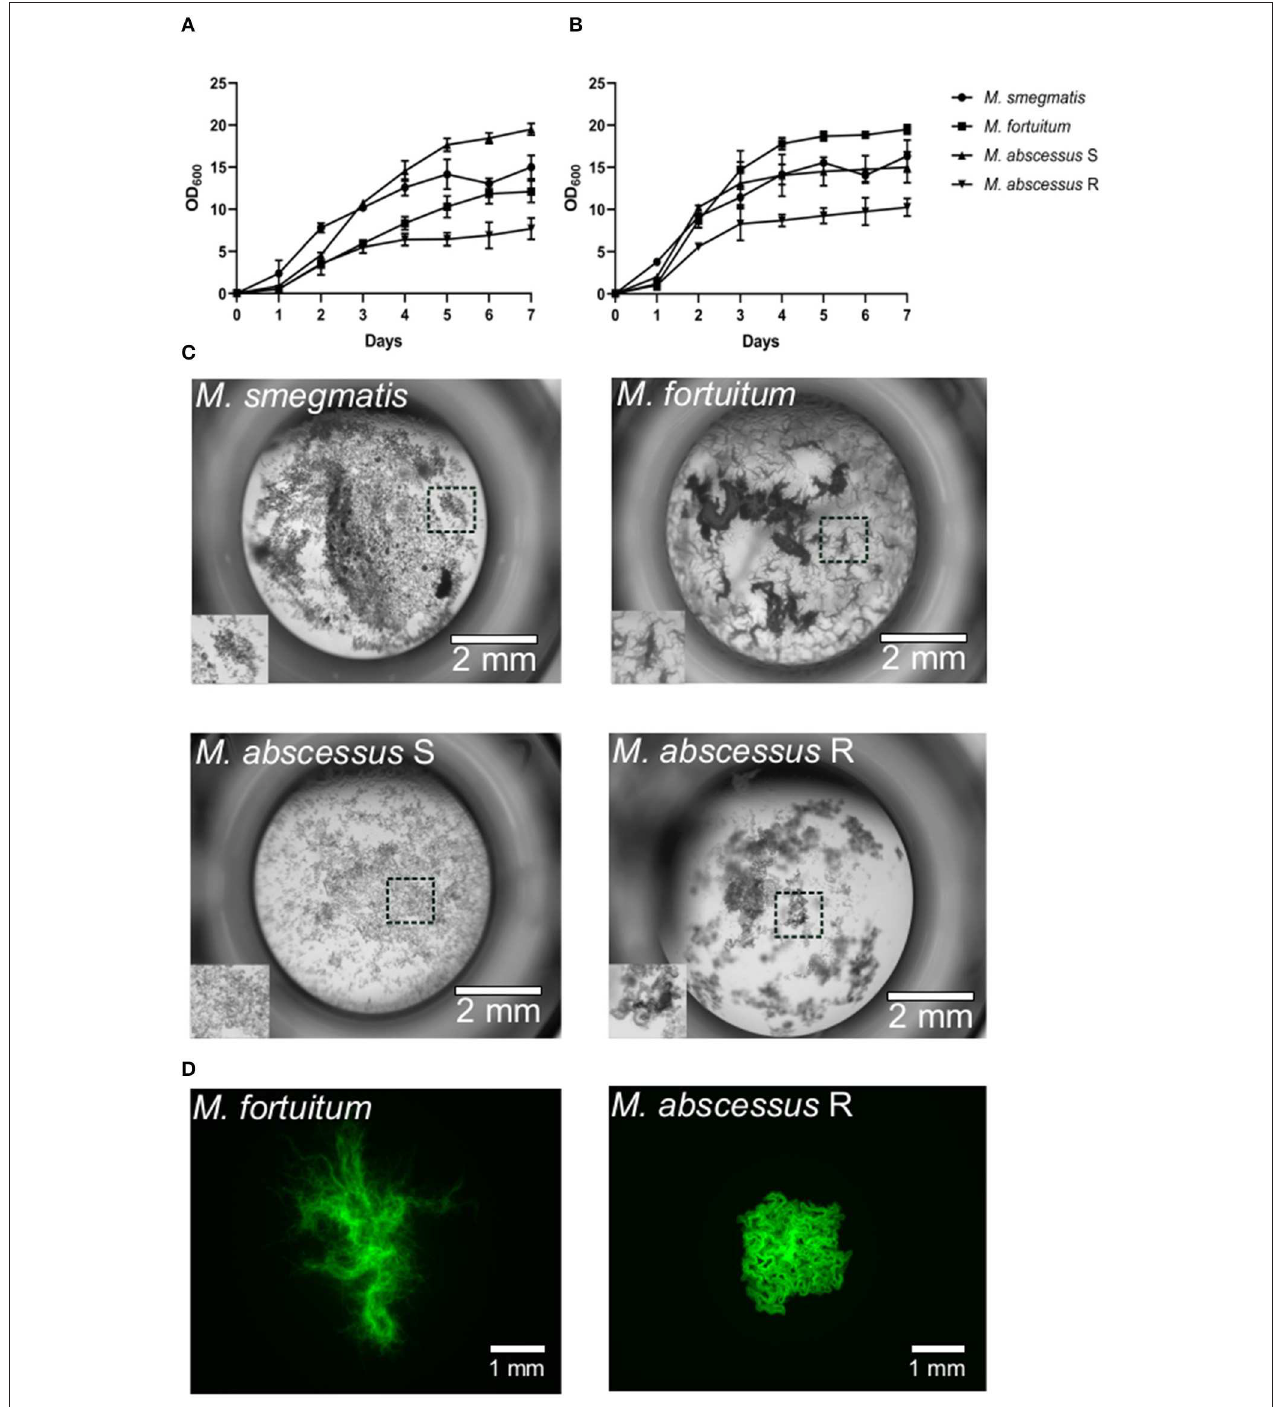
FIGURE 1 | Mycobacterium fortuitum forms large corded bacterial aggregates in vitro . (A) M. abscessus CIP104536 T smooth (S) and rough (R) variants, M. fortuitum subsp. fortuitum (ATCC 6841) and M. smegmatis mc 2 155 were inoculated in 7H9 OADC / T at an optical density of 0.05 (OD 620 ) and incubated at 30 ◦ C and (B) 37 ◦ C under shaking at 100 rpm. Growth measurements were taken daily over a 7-day period until cultures reached stationary phase. Data shown is the merge of two independent experiments. Error bars represent standard deviation. (C) In vitro liquid growth properties of the different NTM species in CaMHB medium following 3–4 days static culture at 30 ◦ C in a 96-well plate. The boxed area depicts the zoomed section of liquid growth in the bottom left hand corner of each well. Scale bars represent 2mm. (D) In vitro solid agar growth properties of M. fortuitum and M. abscessus R variant following 3 days growth at 30 ◦ C. Scale bars represent 1 mm.